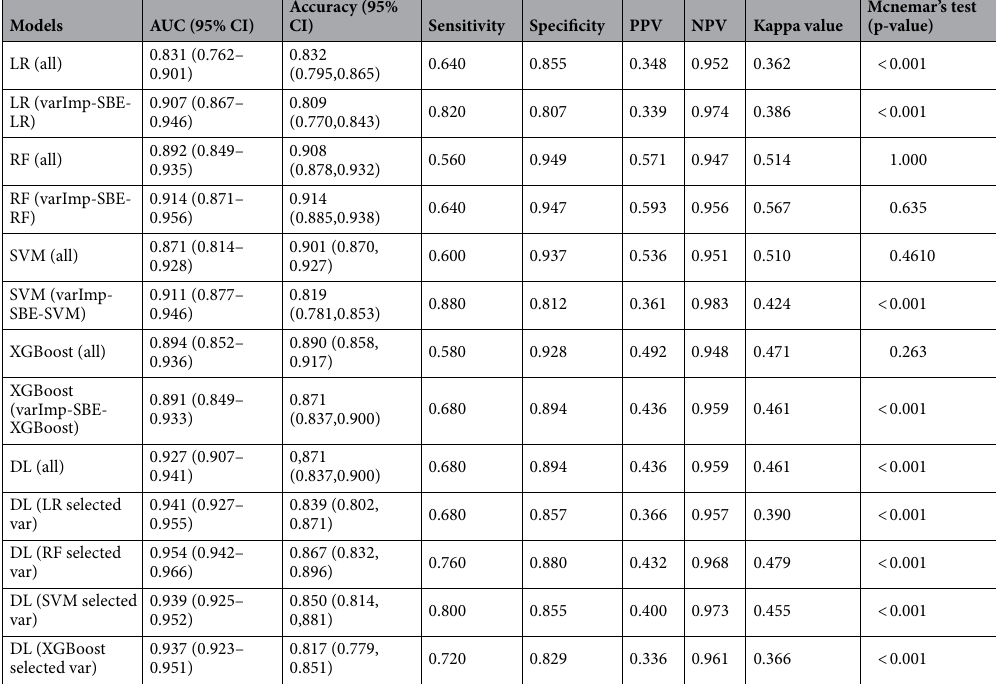
Table 3. The AUC DL and ML models with and without feature selection based on a 30% validation